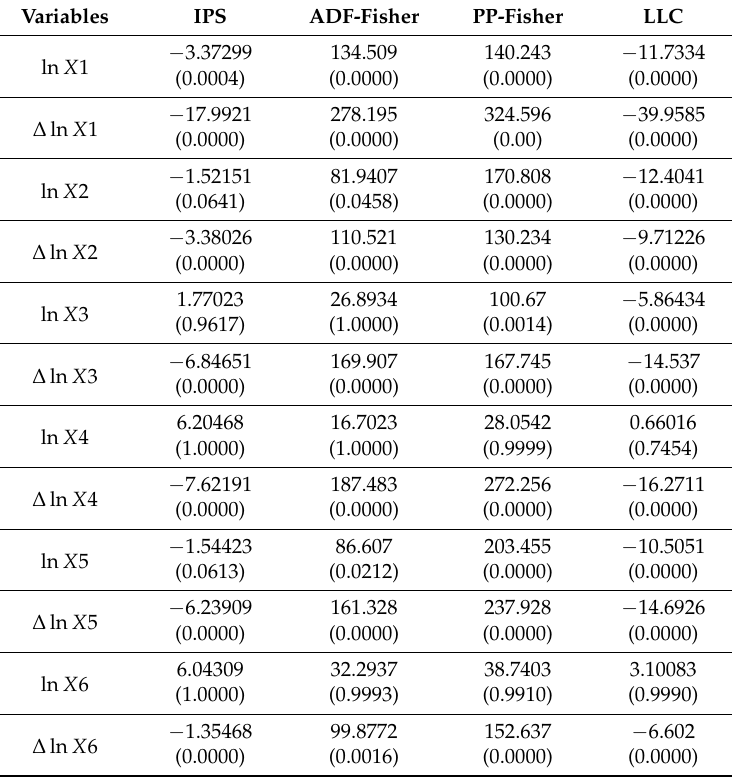
Table 2. Factors’ stationarity test with different